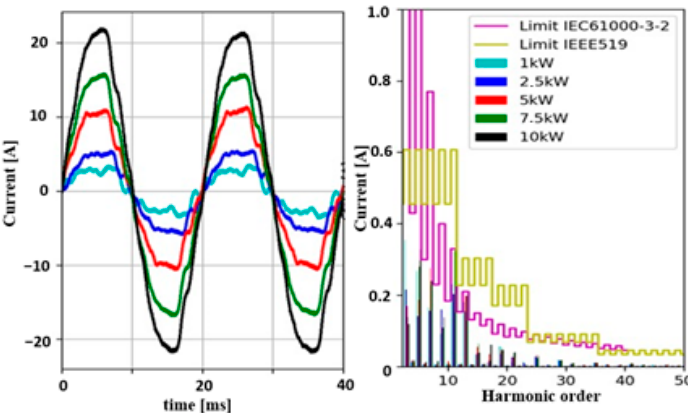
Figure 8. Waveform and Harmonics of the V2G charger at different power levels